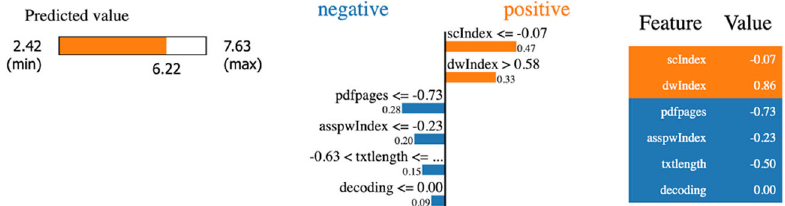
Fig. 8 LIME explanation for a different document in the OpenReview dataset. The top features are: the word “ decoding ” , the sentence count scIndex , the number of dif fi cult words dwIndex , the number of pages pdfPages , the average number of syllables per word asspwIndex , and the text length txtlength .